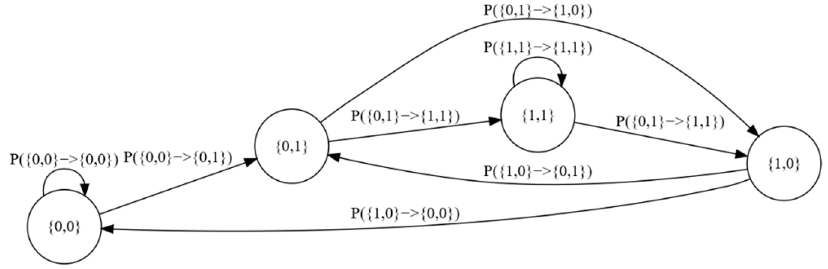
Figure 1. Graph of the market change process in the SMBR(25,2) model. Source: author.